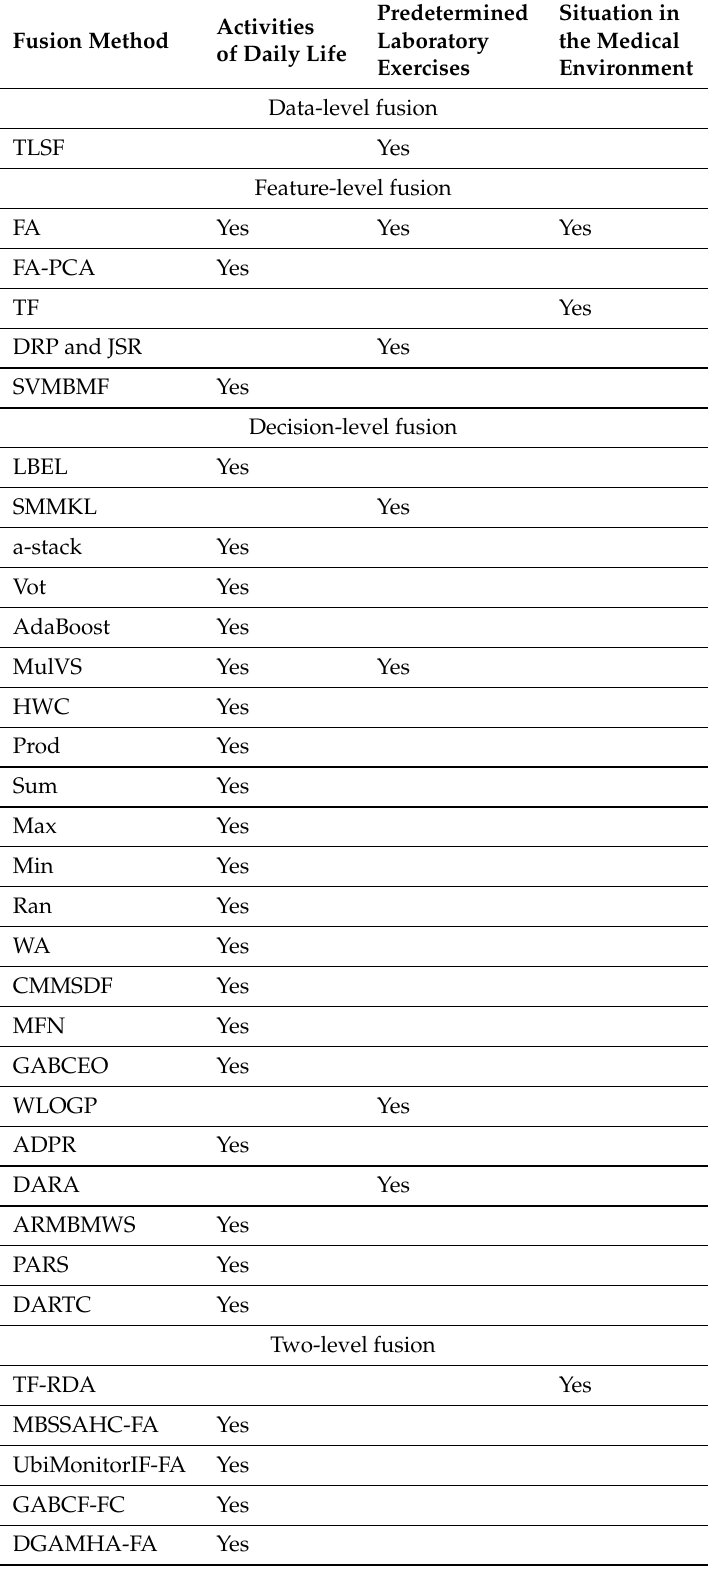
Table 8. Scenarios by fusion